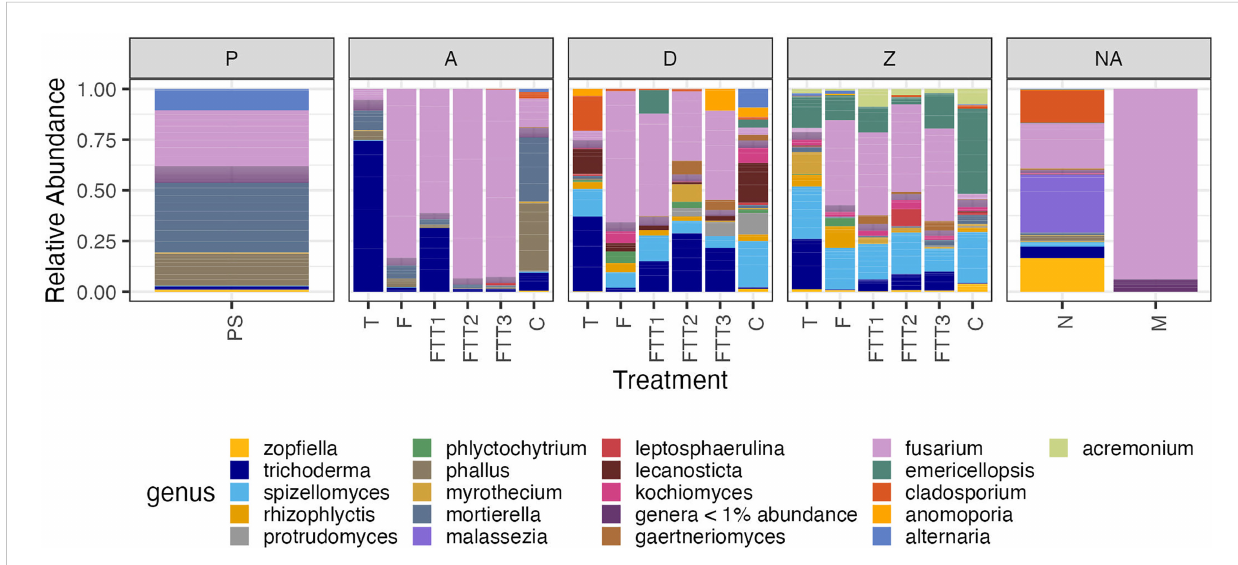
FIGURE 4 The top 20 most abundant genera for the soil steaming, pathogen, and bene fi cial soil addition experiment. Treatment is on the x-axis, and relative read abundance on the y-axis. The treatments were: pre-steam (PS), Trichoderma (T), Fusarium (F), Fusarium Trichoderma Time 1 (FTT1),